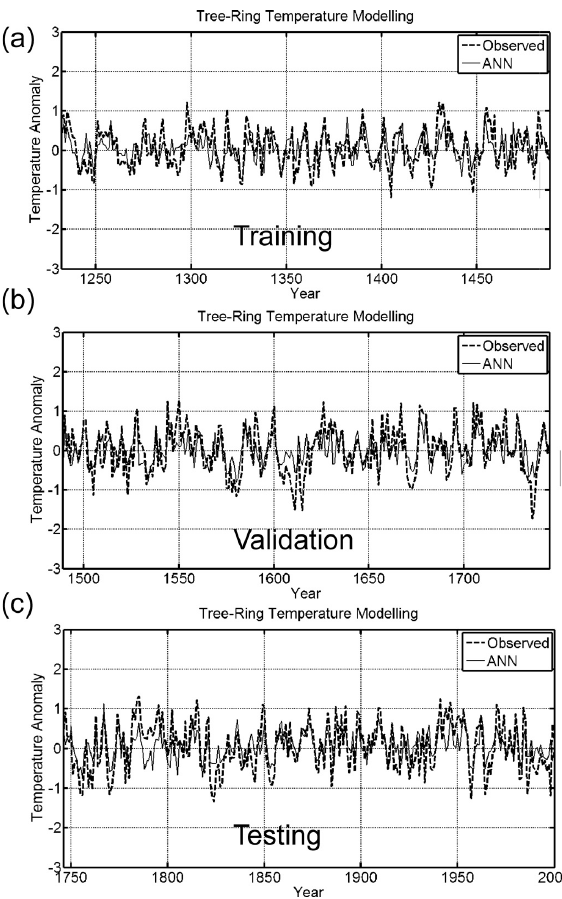
Fig. 10. One lag temperature anomaly reconstruction using Artifi- cial neural network in the period (a) AD1232–1488, (b) AD1489– 1745, (c) AD1746–2000.